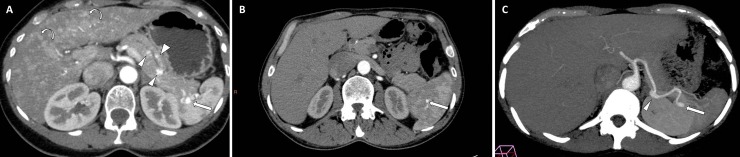
A. SAA in a 52 year-old man with HHT and parenchymal pancreatic involvement. Enhanced computed tomography in axial view show hilar splenic artery aneurysm (arrow) associated with multiple pancreatic telangiectasia (arrowheads). Note the hepatic involvement characterized by heterogeneous enhancement due to multiple hepatic telangiectasia (curved arrows). B. SAA in a 54 year-old man with HHT and a splenic intraparenchymal aneurysm. Enhanced computed tomography in axial view show intraparenchymal splenic artery aneurysm (arrow). C. SAA in a 44 year old woman with multiple locations of SAA (truncular and hilar). Enhanced computed tomography in axial view and maximal intensity projection (MIP) reformation showing an hilar (arrow) and a truncular splenic artery aneurysm (arrowhead).